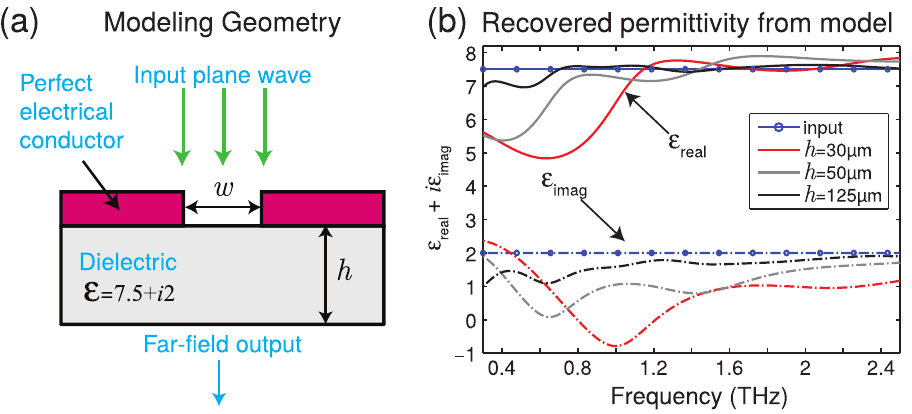
Figure 2. ( a ) Side view of the modelling geometry; a plane wave is incident upon a single aperture placed on top of a dielectric. ( b ) The permittivity recovered from our model for three different dielectric thicknesses of 30, 50 and 125 μ m . The fields processed for the permittivity are due to the complex summation of the far fields transmitted through apertures of sizes from 40 to 700 μ m